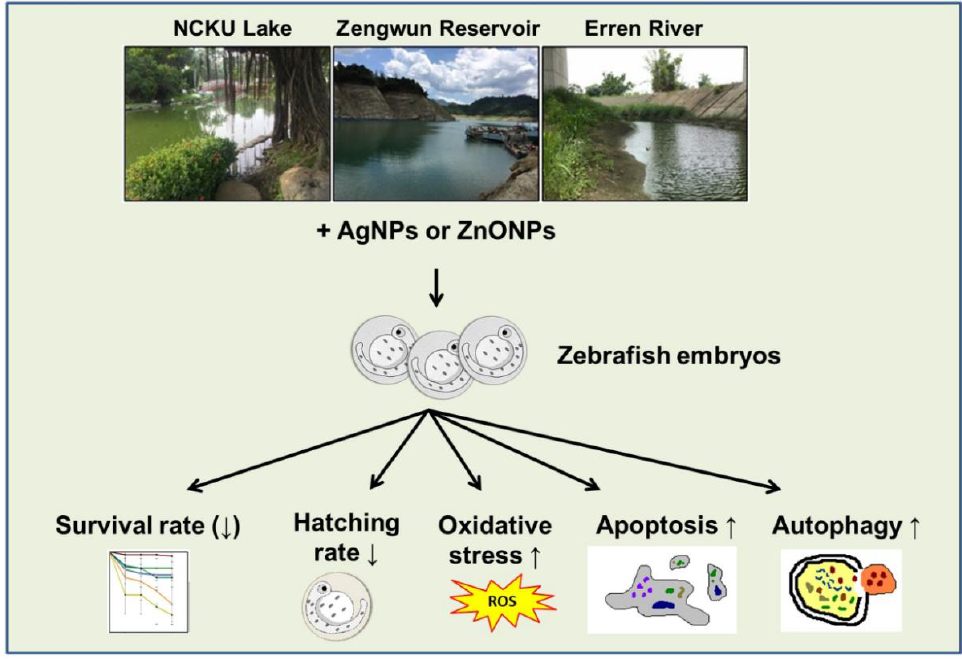
Figure 9. Illustration of the toxic mechanisms of AgNPs and ZnONPs spiked into natural water. The NP suspension was spiked in natural water obtained from NCKU Lake, Zengwun Reservoir, and Erren River and caused lethality and developmental toxicity in embryos. Mechanistically, AgNPs and ZnONPs spiked in natural water induced excessive ROS production, programmed cell death, and overactivated autophagy. AgNPs, silver nanoparticles; ZnONPs, zinc oxide nanoparticles.